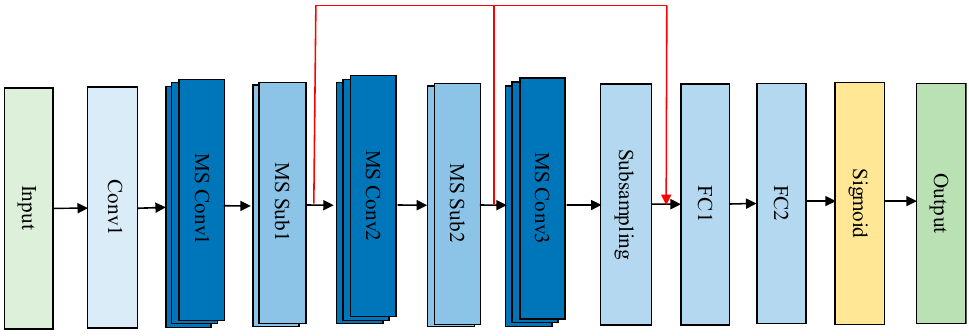
Figure 3. The structure of the multi-scale short cut convolutional neural network (MS-SC-CNN) model.